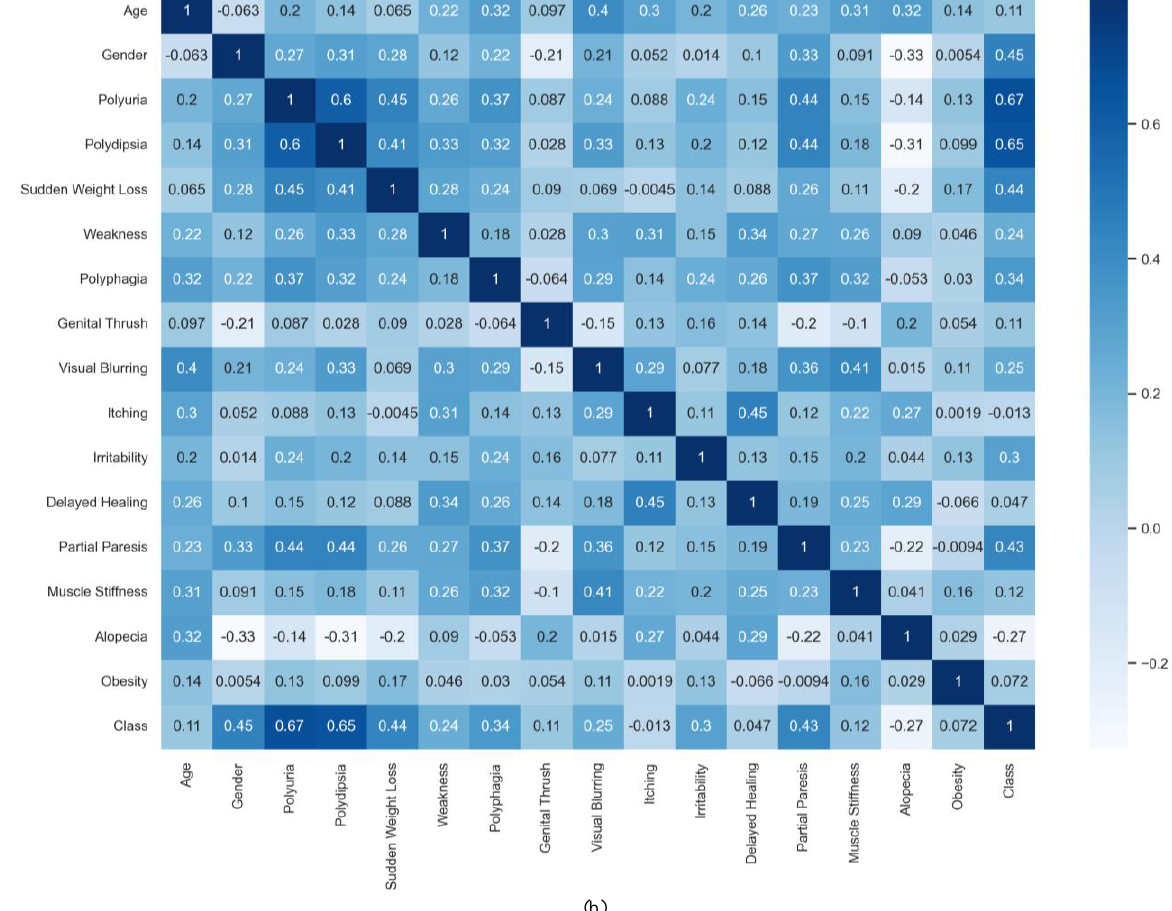
Figure 2. a: Correlation Between Attributes of Pima diabetes dataset, b: Correlation between Attributes of Early-stage diabetes dataset